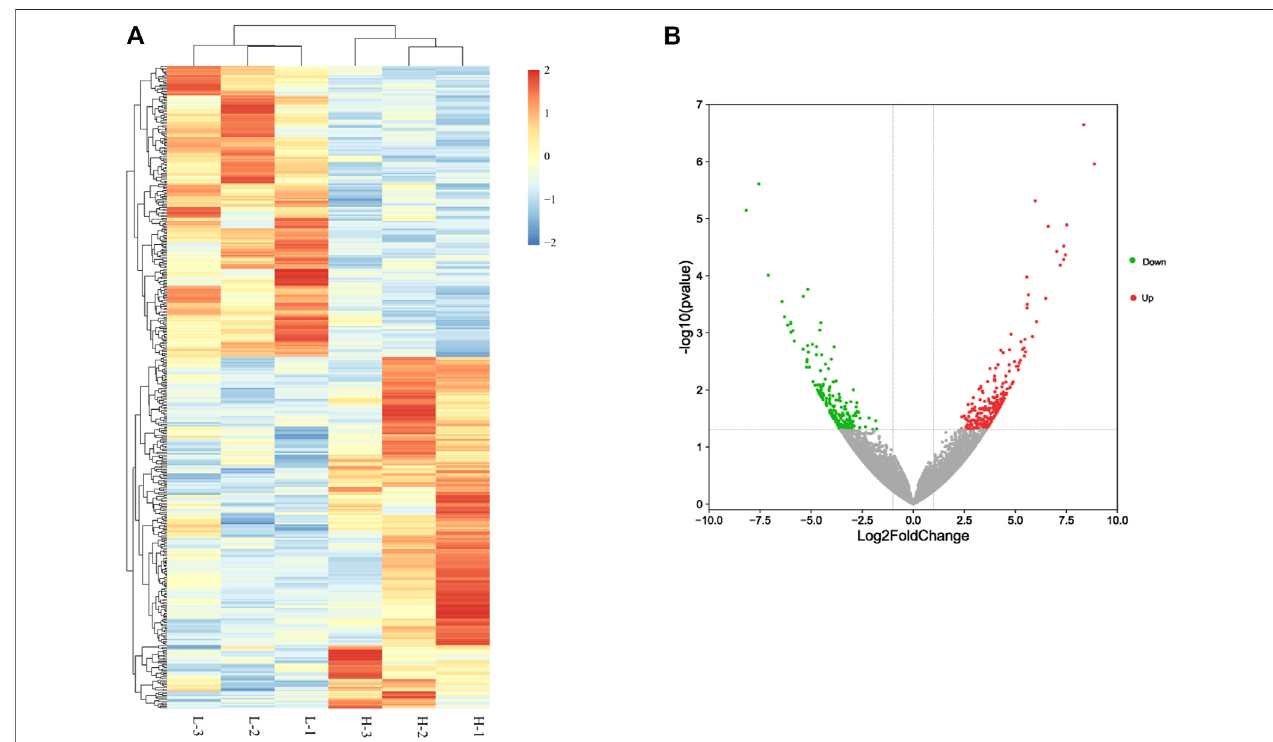
FIGURE 1 | Differentially expressed genes between high – and low – egg-yielding groups of Taihang chicken. (A) Hierarchical clusters of differentially expressed genes. H represents the high – egg-producing group and L represents the low – egg-producing group. (B) Volcano plot of differentially expressed genes in chicken small yellow follicles. Red dots represent upregulated genes and green dots represent downregulated